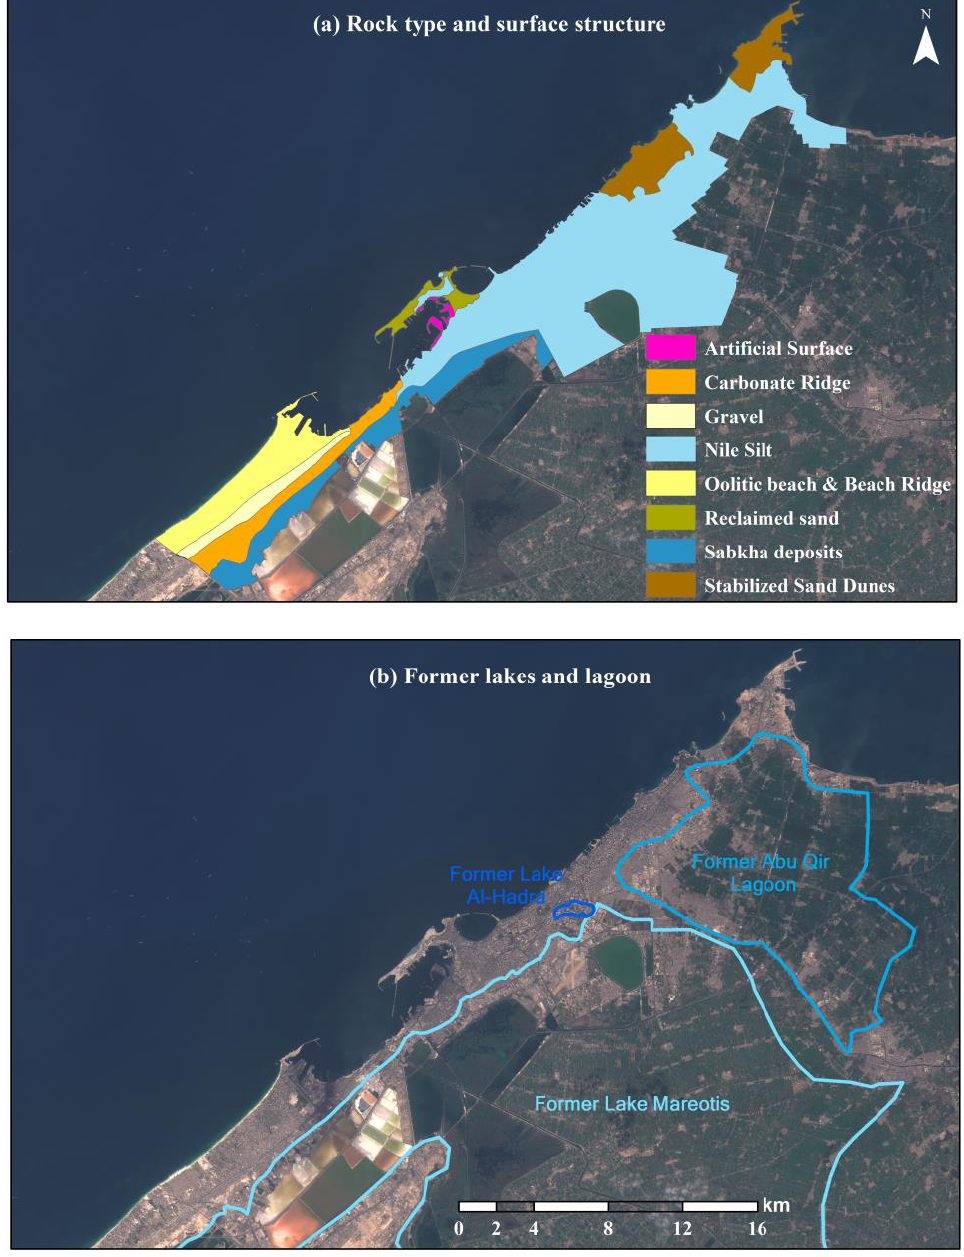
Figure 3. Rock type and former lakes and lagoons (FLL) in the study area, ( a ) rock type and surface structure of the city, ( b ) former lakes and lagoons in Alexandria.